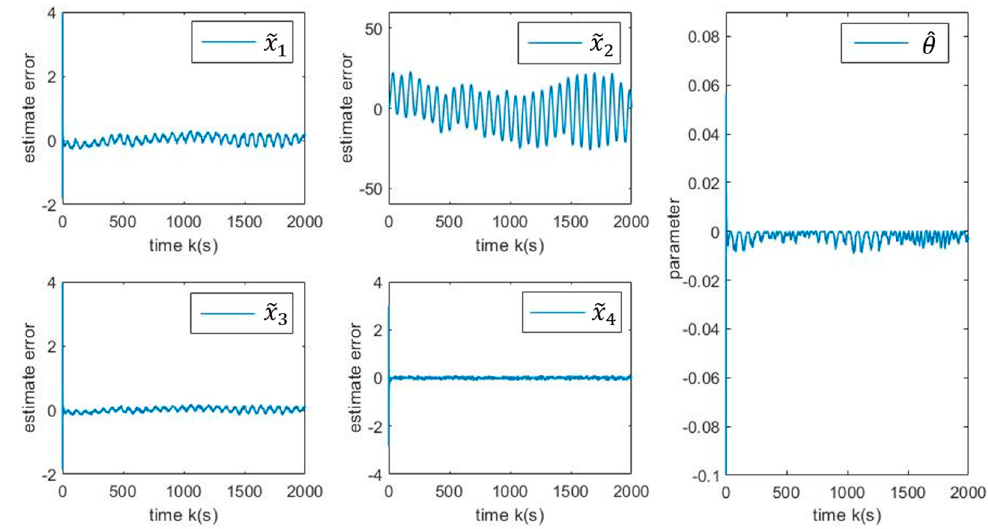
Figure 2. Error vector and parameter response trajectories for the error system in Example 2.